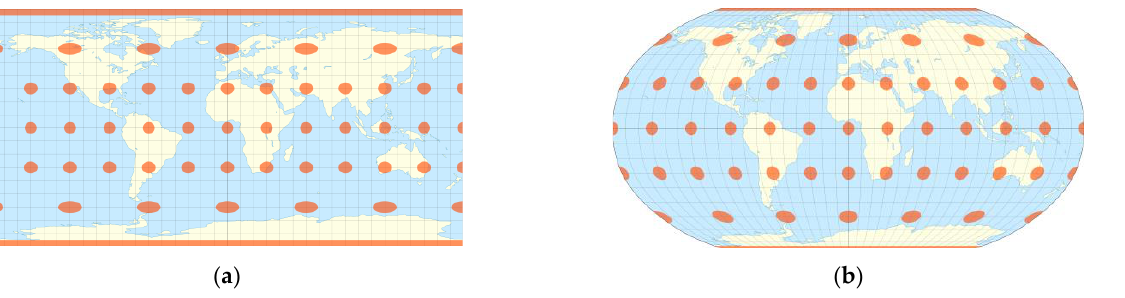
Figure 7. Tissot’s Indicatrix depicting the distortions for ( a ) plate carrée and ( b ) Robinson pseudo-cylindrical projection (Acknowledgement: Justin Kunimune) [72,73].